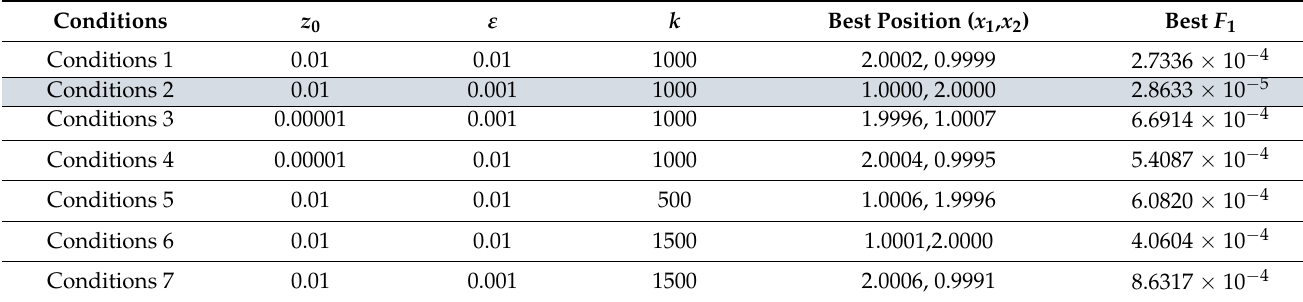
Table 4. Results of case 1: F 1 at different conditions.